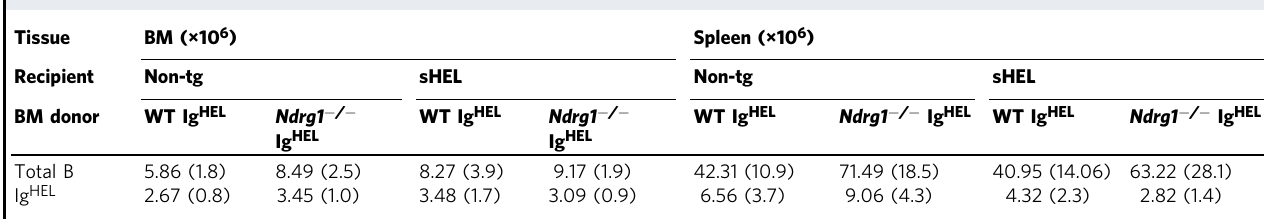
refractory mechanisms in place to inhibit autoreactive B cell responses to LPS do not depend upon NDRG1 expression (Fig. 4i).